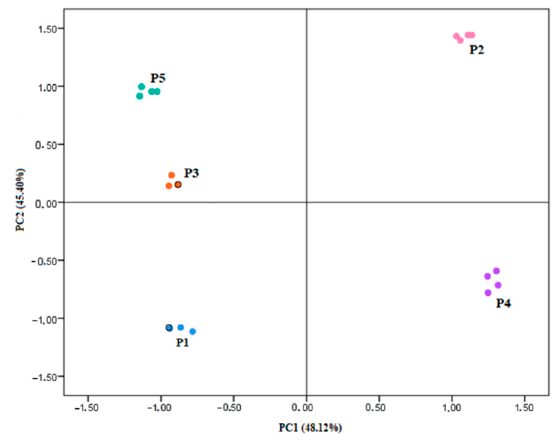
Figure 9. Score plot of the principal components PC1 and PC2.